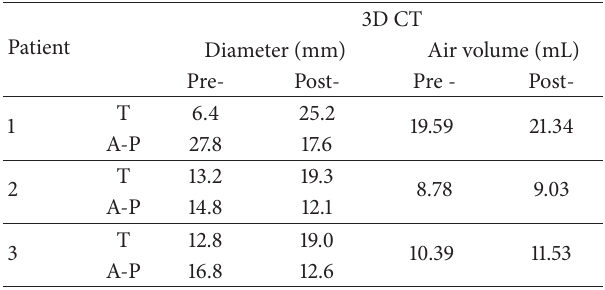
Table 2: Anatomical measures from 3D CT before and after